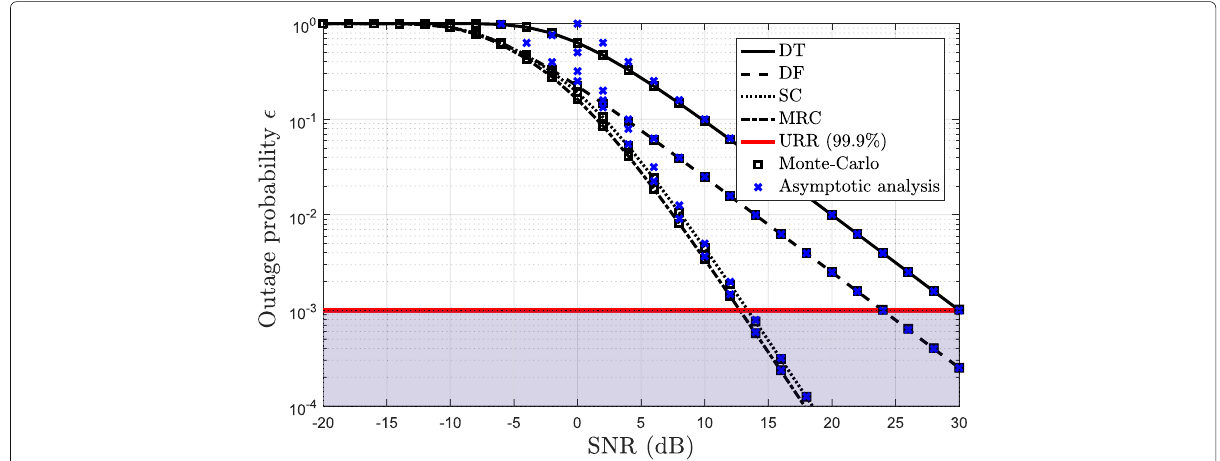
Fig. 6 Performance analysis of cooperative protocols under EPA. This figure compares the power consumption of studied cooperative schemes to direct transmission under the equal power allocation strategy. We show that under EPA, MRC requires less transmit power to work under ultra-reliable region compared to the other studied cooperative relaying protocols. Monte-Carlo simulations confirm the accuracy and appropriateness of our analytical model. In addition, asymptotic expressions approach the analytical results as the SNR